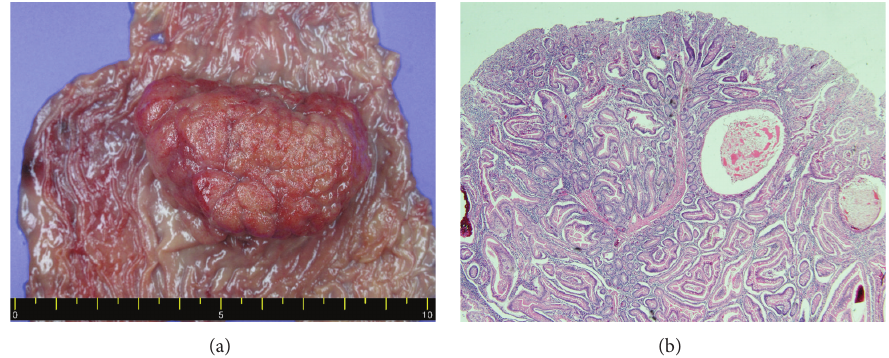
Figure 4: Histologic findings. (a) Gross image shows a 6 × 3.7 cm sized solitary polyp in jejunum. (b) Microscopically, the polyp showed cystic dilation and many branched tortuous glands surrounded by an inflammatory stroma, which were consistent with a juvenile polyp. Hematoxylin-eosin stain